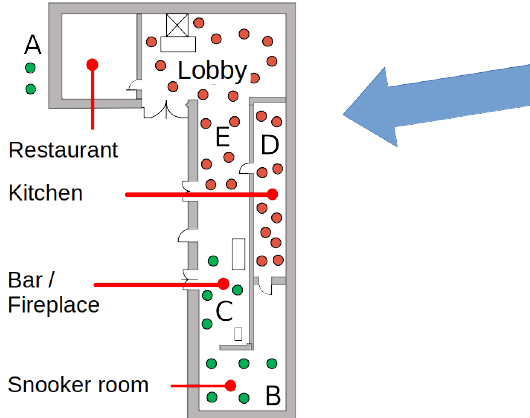
Figure 10. Plan view of the hotel/spa complex and location of the survivors (green dots) and victims (red dots). Approximate flow direction and area of strongest impact indicated by large arrow. Based